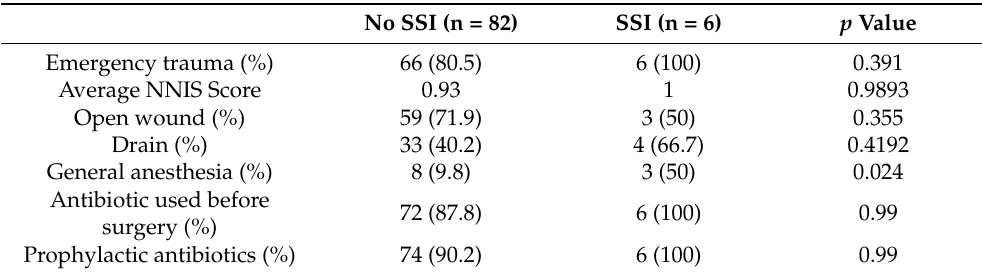
Table 2. Risk factors associated with surgical site infection (SSI) in orthopedic patients.